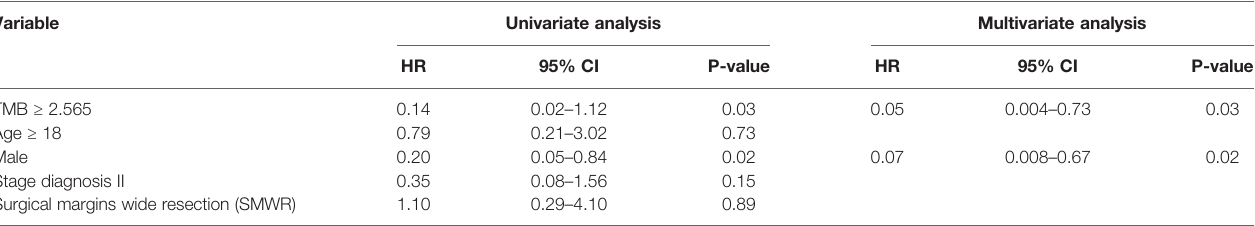
FIGURE 4 | Improved OS in patients with high TMB. TMB was strati fi ed with a binary cutoff of 2.565 (3rd quartile). Log-rank test was used to calculate P value. (A) OS curves of TMB-High and TMB-Low groups ( P = 0.03). (B) OS curves of patients strati fi ed by the combination of Gender and TMB. TMB-High Males (n=5), TMB-High Females (n=3), TMB-Low Males (n=12), TMB-Low Females (n=10) ( P =0.005). The numbers in parentheses represented the number patients in each group. TABLE 4 | Analysis of factors associated with OS.